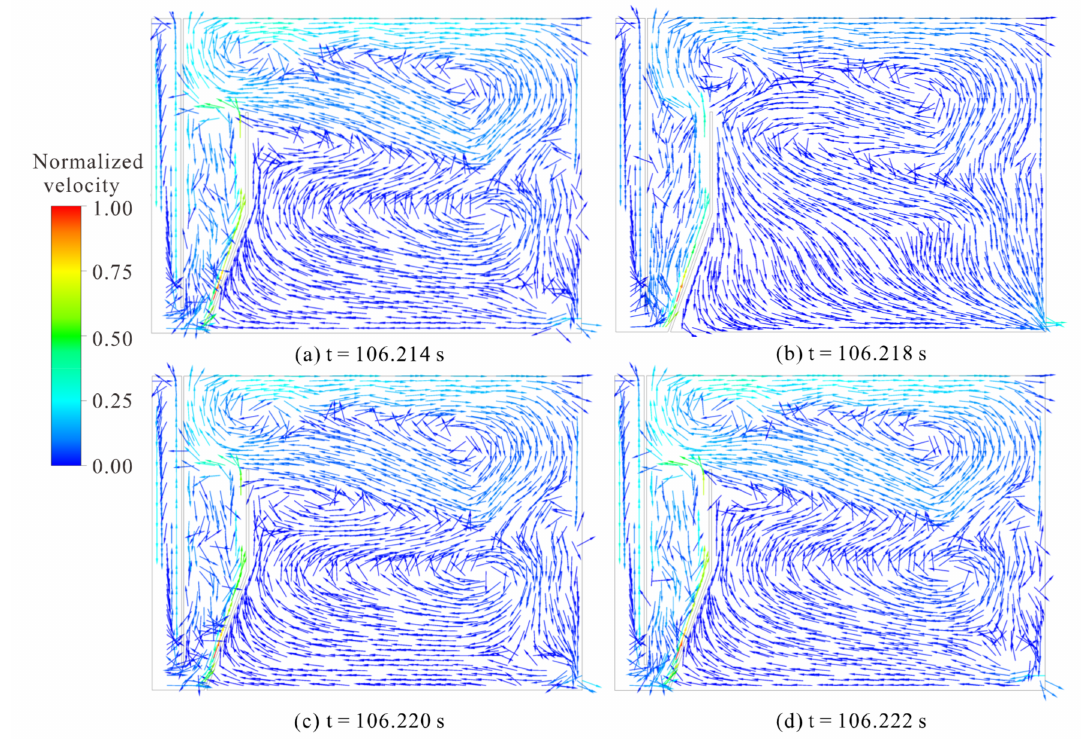
Figure 3. Velocity profile before and after the maximum velocity generated by the fluidic oscillator in the FAF tank. ( a ) Velocity profile before the maximum velocity, ( b ) velocity profile at the maximum velocity, and ( c ) and ( d ) velocity profile after the maximum